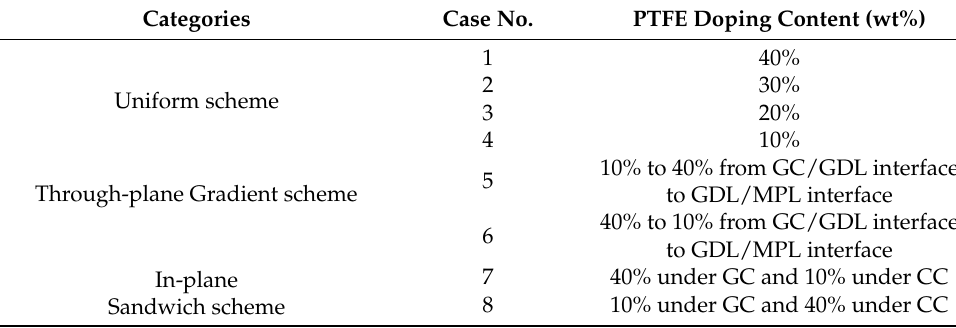
Table 6. Categories of PTFE doping